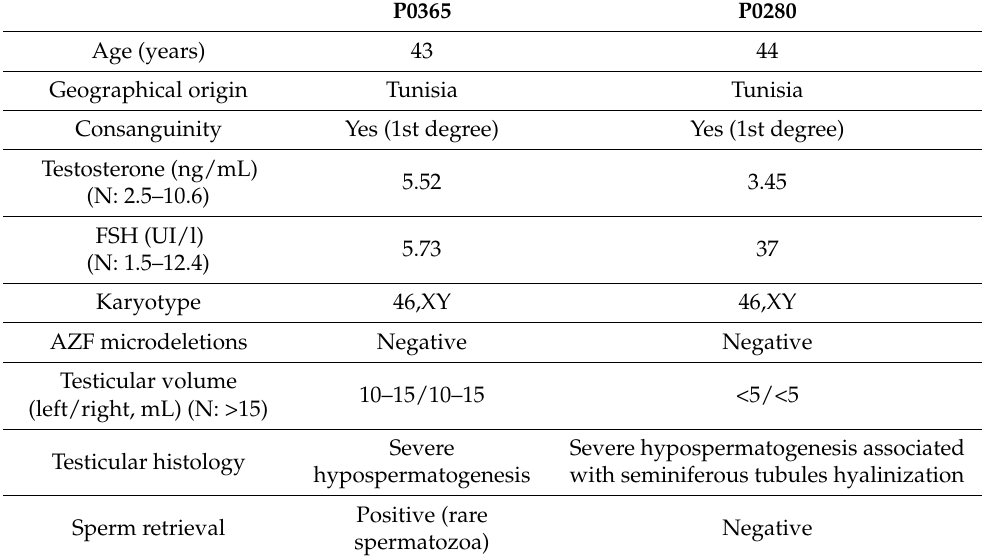
Table 1. Clinical and biological characteristics of the studied